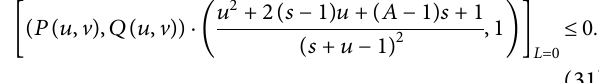
Figure 1: Poincar´e map φ related to the impulsive point series v + TH � 0 . 6, and τ � 0 . 3. (a) D � 1. (b) D � 0 .